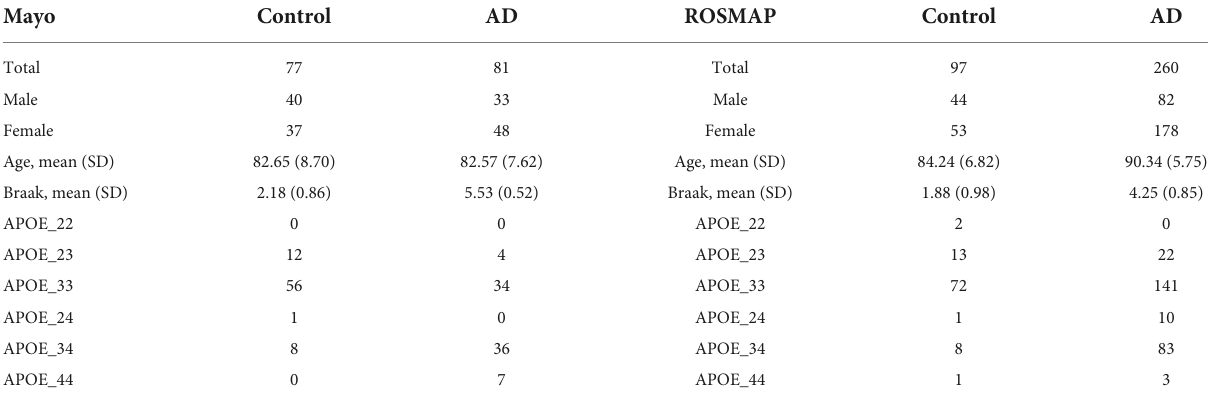
TABLE 1 Epidemiology information of Mayo and ROSMAP datasets.